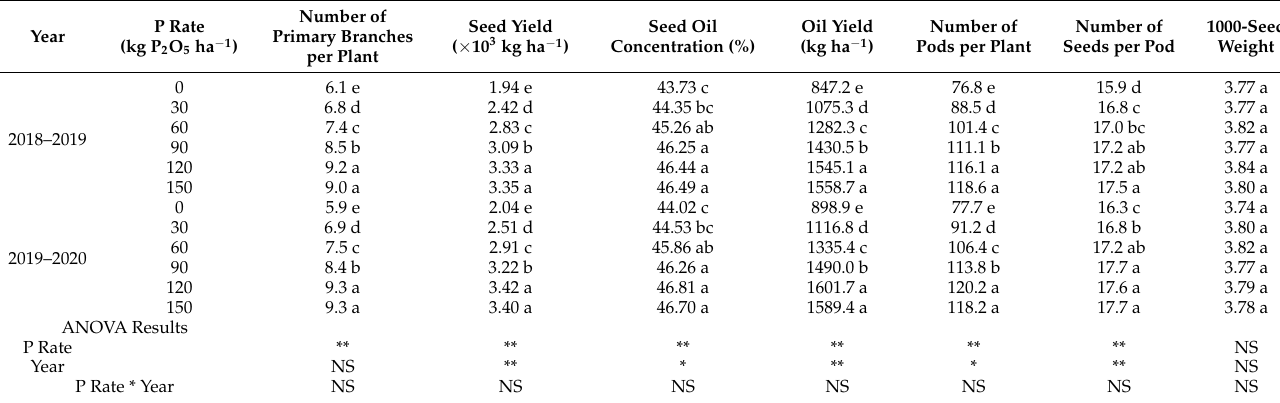
Table 2. Effects of P rate on yield performance of canola plants in saline environment.